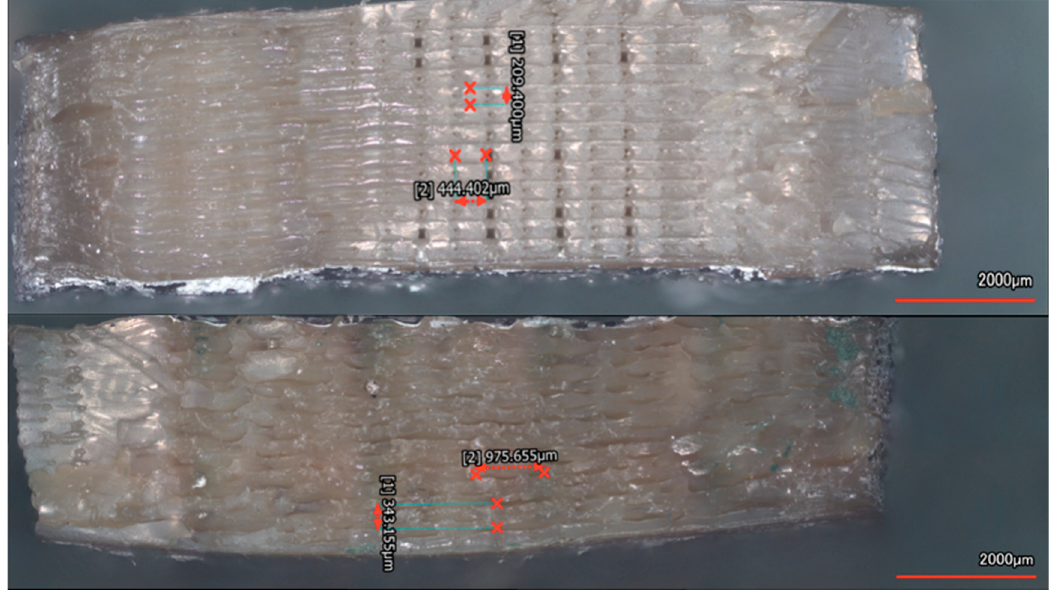
Figure 6. Cross-section of a sample made with 0.12 mm layer height and a 0/90 raster angle, con- trasted with a part made with 0.21 mm layer height and a 45/45 raster angle.